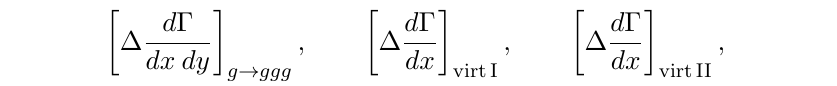
Figure 7 . A few examples of diagrams involving either (i) instantaneous interactions via longitudi- nal gluon exchange or (ii) fundamental 4-gluon vertices. Longitudinal gluon exchange is represented by a vertical (i.e. instantaneous) line that is crossed by a black bar, following the diagrammatic notation of Light-Cone Perturbation